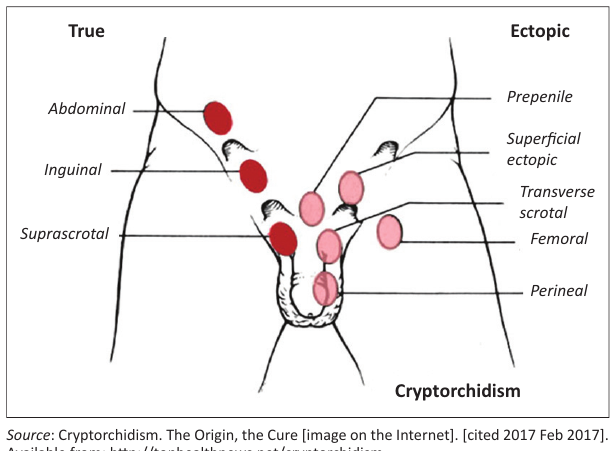
FIGURE 1: The most frequent locations of true and ectopic undescended testis.